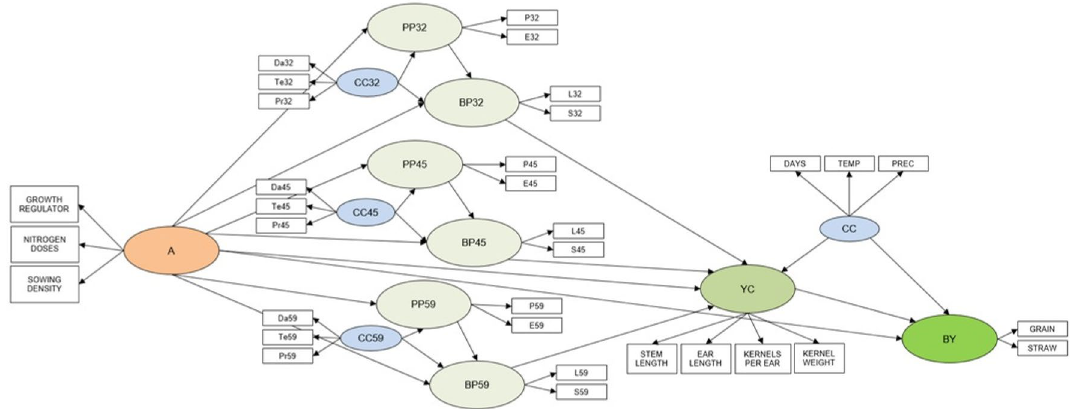
Figure 4. A generic diagram of the PLS-PM structural model describing the relationship between latent and manifest variables denoting T. durum plant growth and development (refer to Table 1 for the